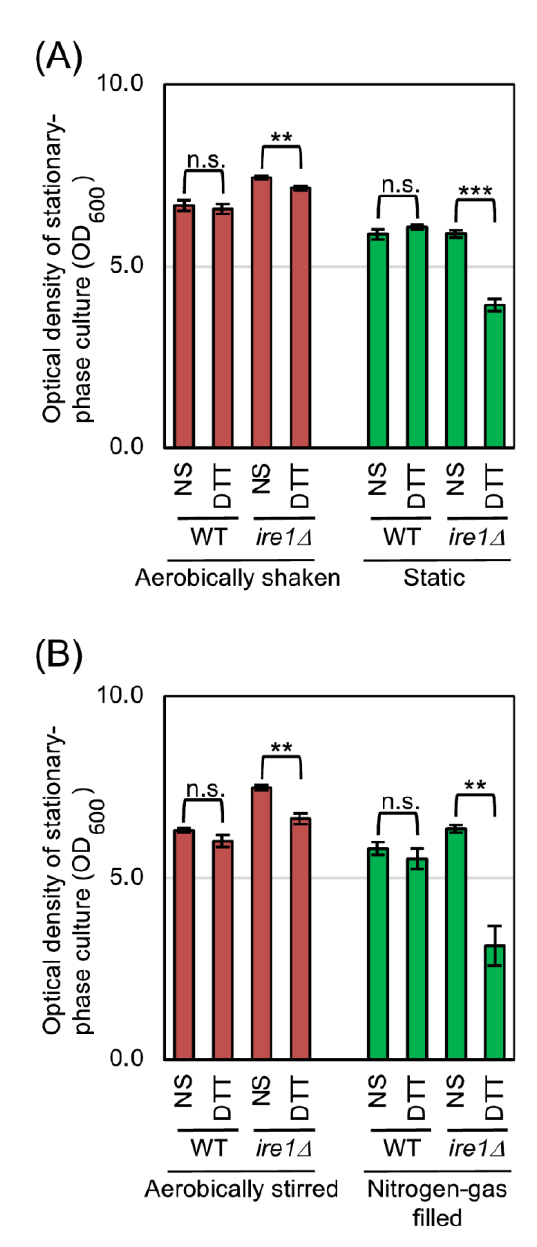
FIGURE 3: Hypoxic treatment aggravates ER stress-induced cellular damage. (A) Wild-type BY4742 cells and the congenic ire1  mutant were cultured as shown in Fig. 1A, and optical density of the